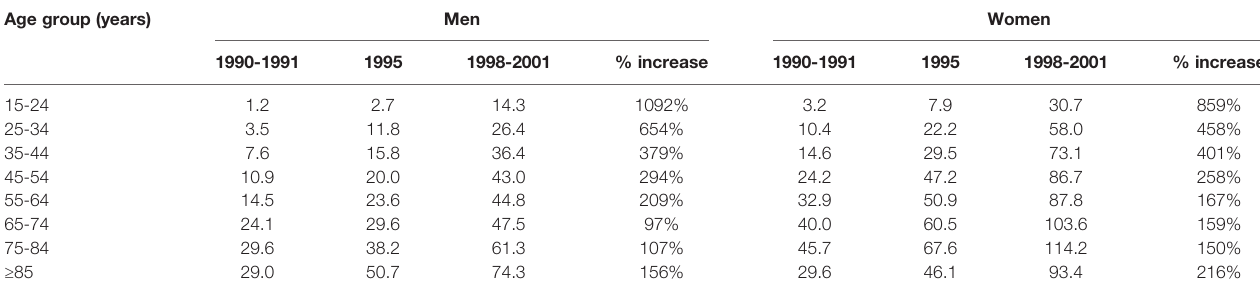
TABLE 2 | Estimated use of antidepressants (de fi ned daily dose/1000 people/day) in Australian by sex and age, 1990-2001. Age group